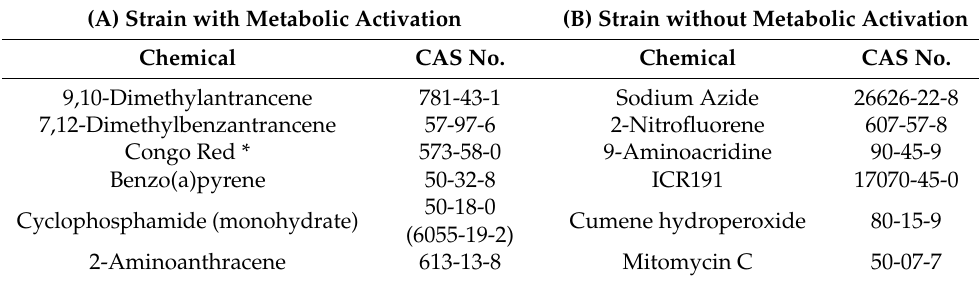
Table 1. Positive controls for strains with metabolic activation ( A ) and without metabolic activation ( B